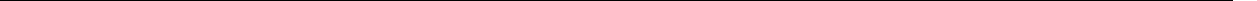
Fig. 6 Clathrin-dependant internalization of CXCR3-A. Western blot ( a ) and immunostaining ( b ) for clathrin in U87-CXCR3-A cells treated with control siRNA (Si CTRL) or siRNA against human Clathrin heavy chain (Si Clathrin, smart pool of four siRNA, Dharmacon). Tubulin used as a loading control in the western blot. Scale: 50 µ m. a.u. arbitrary unit. *** P < 0.001. c Membrane or perinuclear localization of CXCR3 ( λ = 547 nm) with Si CTRL or Si Clathrin. Scale: 5 µ m. d FACS analysis of the percentage of CXCR3 at the membrane on U87-CXCR3-A cells treated with Si CTRL or Si Clathrin. *** P < 0.001. e Clathrin-dependent internalization of CXCR3-A. Cells were preincubated with the clathrin inhibitor Pitstop 2tm. Analysis by immuno fl uorescence at ×630 magni fi cation under confocal laser scanning microscope (Nikon eclipse Ti). Scale: 5 µ m. f Constitutive internalization of CXCR3-A shown by FACS analysis in HEK-CTRL/HEK-CXCR3-A (left panel) and in U87-CTRL/U87-CXCR3-A (right panel) cells. g Cells were preincubated with the Pitstop 2tm and relative calcium fl ux assessed in U87-CTRL and in U87-CXCR3-A cells. NS non-stimulated condition, DMSO negative control, 20 s PS 20 s post stimulation, 3 min PS 3 min post stimulation, a.u. arbitrary unit, NS non-signi fi cant, *** P < 0.01. All the results represent three independent experiments combined to calculate mean and SEM. Statistical comparison between two groups was performed using the Mann – Whitney U -test. Multiple comparisons were performed with one-way analysis of variance, followed by Bonferroni post hoc